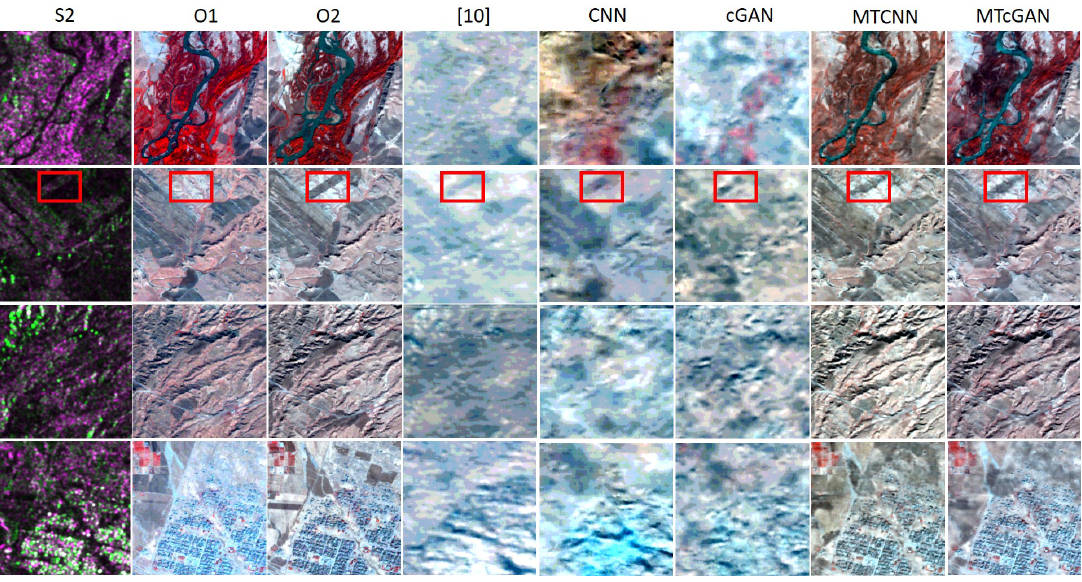
Figure 7. Simulated images of different methods in Case 1, companied with the input images (S2 and O1) and output reference image (O2).